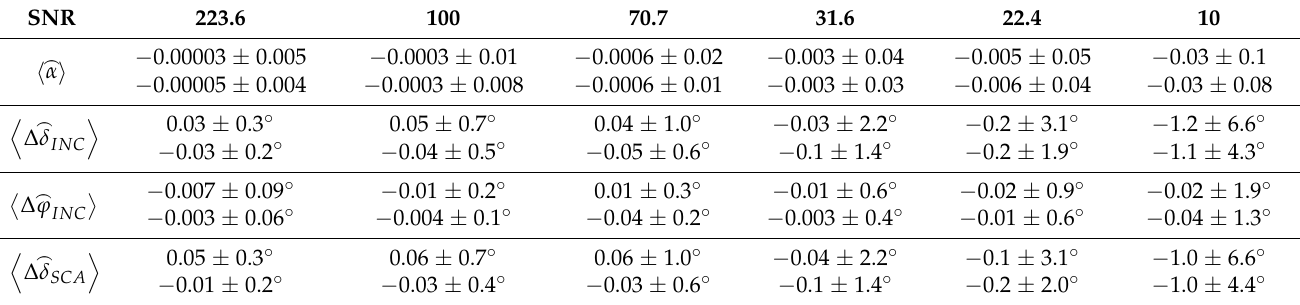
Table 1. Estimations of the average deviations of the calibration parameters depending on the